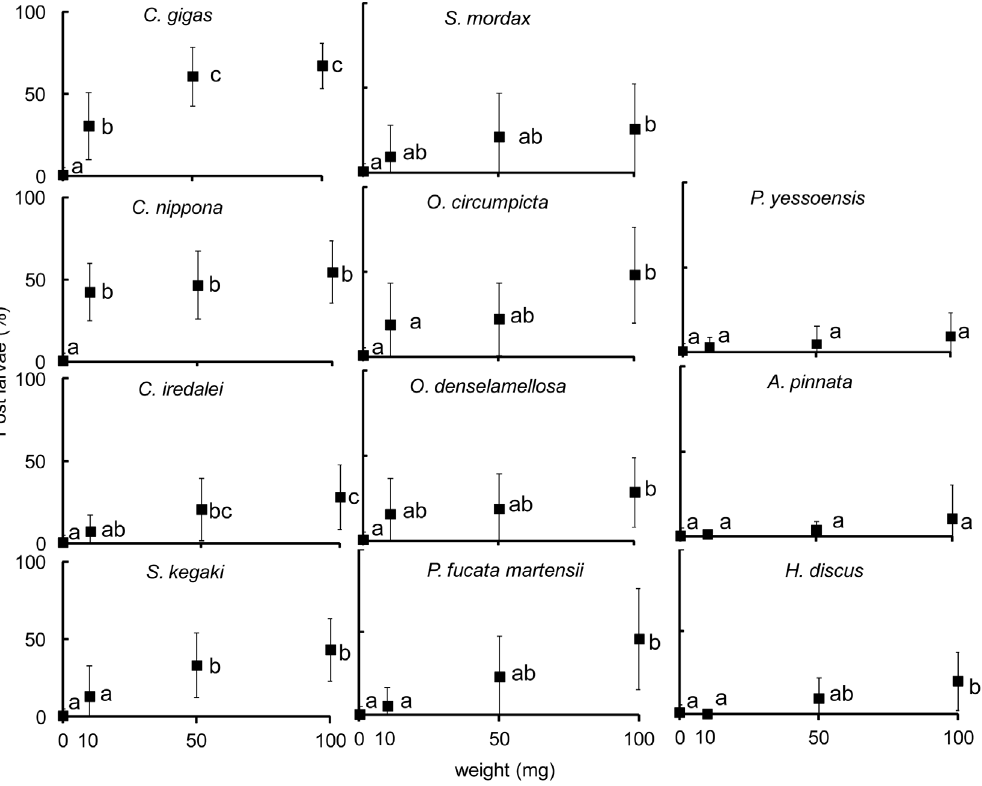
Figure 2. Percentages of post larvae that settled on SC of the different species of mollusks. Closed squares are means of 6 to 30 replicates and error bars represent standard deviation (SD). Letters indicate results of the post hoc Tukey HSD test of activities within species at 0, 10, 50 and 100 mg. Values connected by the same letter are not significantly different (p $ 0.05). doi:10.1371/journal.pone.0082358.g002 PLOS ONE |